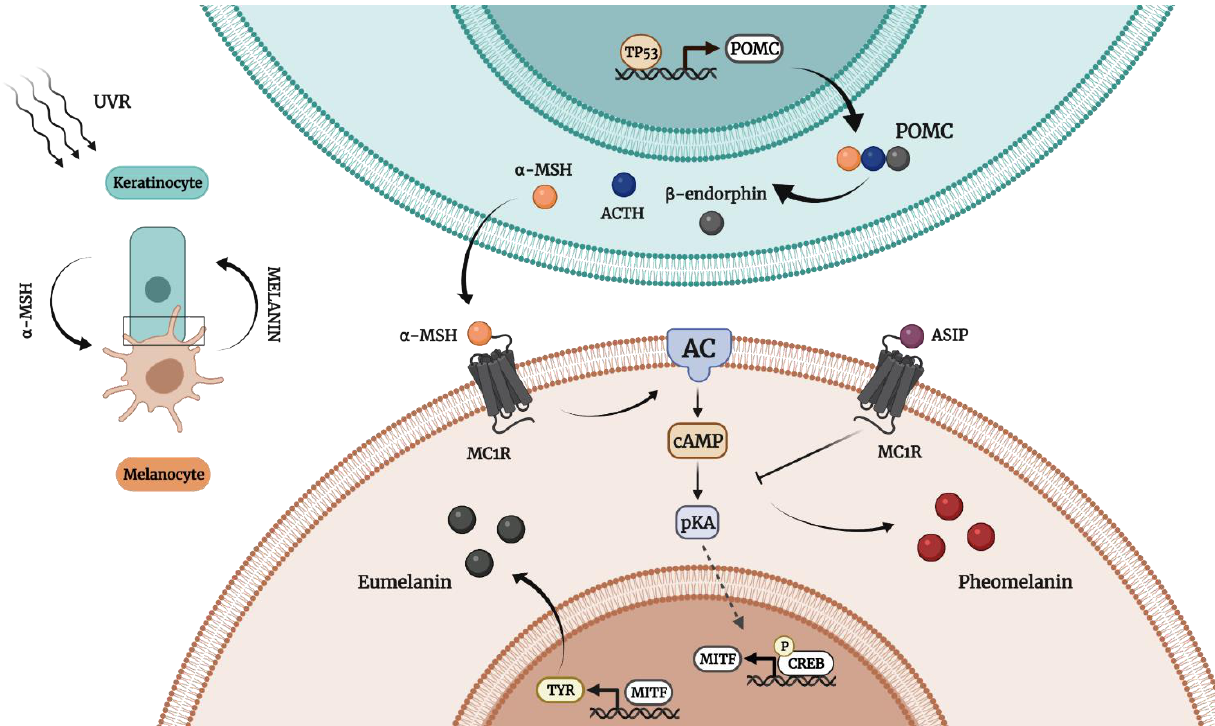
Figure 2. Illustration of the key components in the signaling pathway of melanin synthesis. Keratinocytes trigger epidermal melanogenesis in response to UVR as follows: α-MSH is secreted by keratinocytes and stimulates MC1R, MC1R activates melanogenesis and TYR transcription, TYR promotes eumelanin synthesis, and ASIP blocks MC1R, leading to pheomelanin synthesis. This image was created using BioRender (BioRender.com).